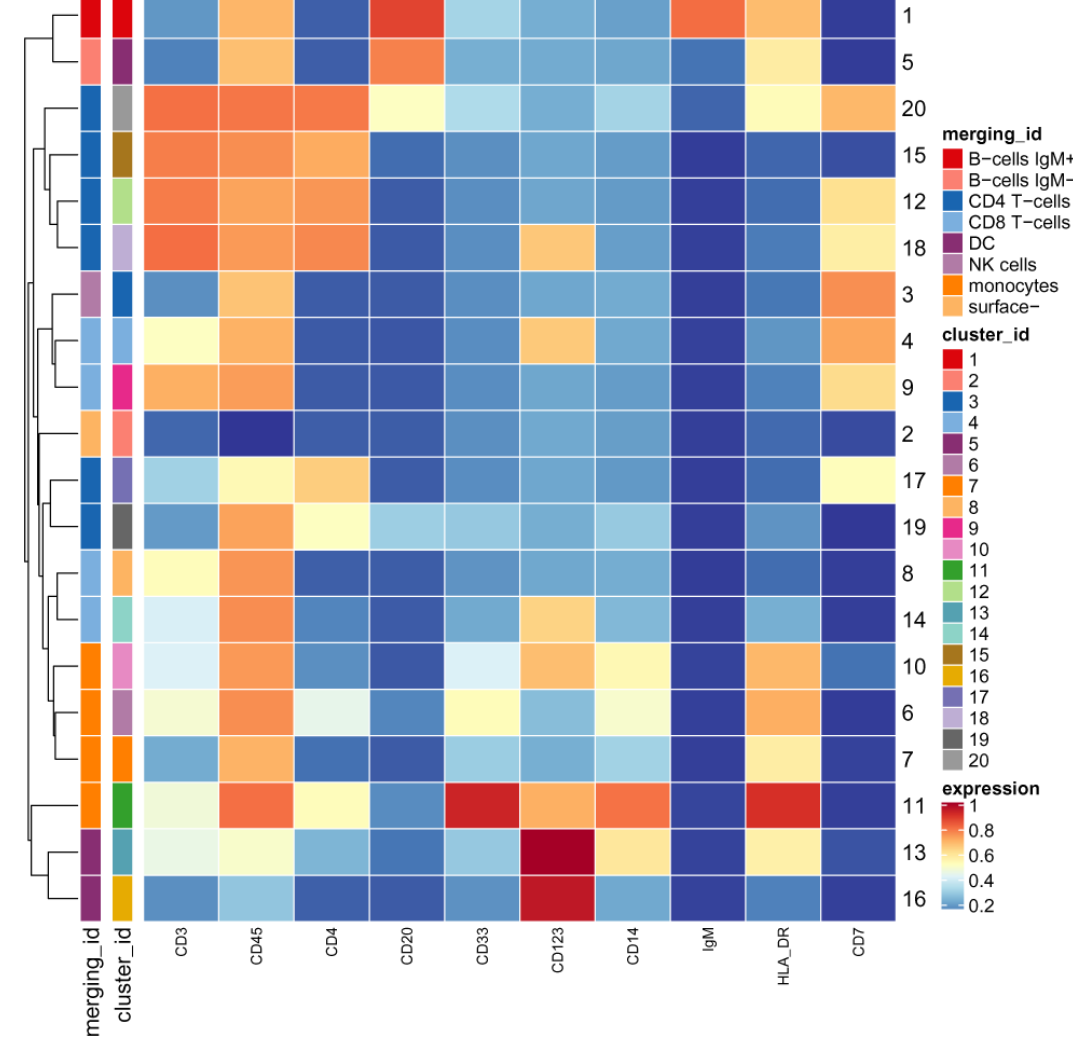
finding the “natural” number of clusters present in the data, which would correspond to the value of k where there is no appreciable increase in stability. This strategy can be referred as the “elbow criterion”. For more details about the meaning of this plot, the user can refer to the original description of the consensus clustering method 43 . The elbow criterion is quite subjective since the “appreciable” increase is not defined exactly. For example, in the delta plot below, we could say that the last point before plateau is for k=6, or for k=5, or for k=3, depending on our perception of sufficient decrease of the delta area score. Moreover, the exact point where a plateau is reached may vary for runs with different random seeds, the drop may not always be so sharp and the function is not guaranteed to be decreasing. It is advisable to investigate more of these plots and the resulting UMAP and heatmaps before drawing any conclusions about the final number of “natural” clusters. Manual merging of up to 20 clusters can be laborious. To simplify this task, one could reduce the strength of over-clustering and allow the metaclustering method to do a part of the merging, which then can be completed manually. Analyzing the delta plot from the right side, we can see how much we can reduce the strength of